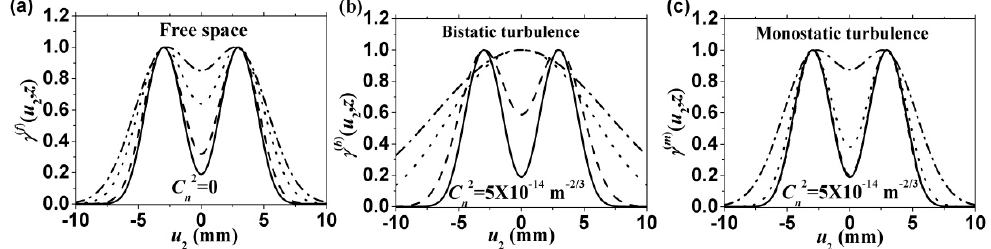
Figure 4. Lensless ghost imaging for different propagation distances ( a ) in free space, ( b ) in bistatic turbulence with C 2 n = 5 × 10 − 14 m − 2/3 and ( c ) in monostatic turbulence with C 2 n = 5 × 10 − 14 m − 2/3 . Solid lines z = 1 m; dashed lines z = 150 m; dotted lines z = 300 m; dashed dotted lines z = 400 m. In ( c ), the solid line and the dashed line are almost overlapped.